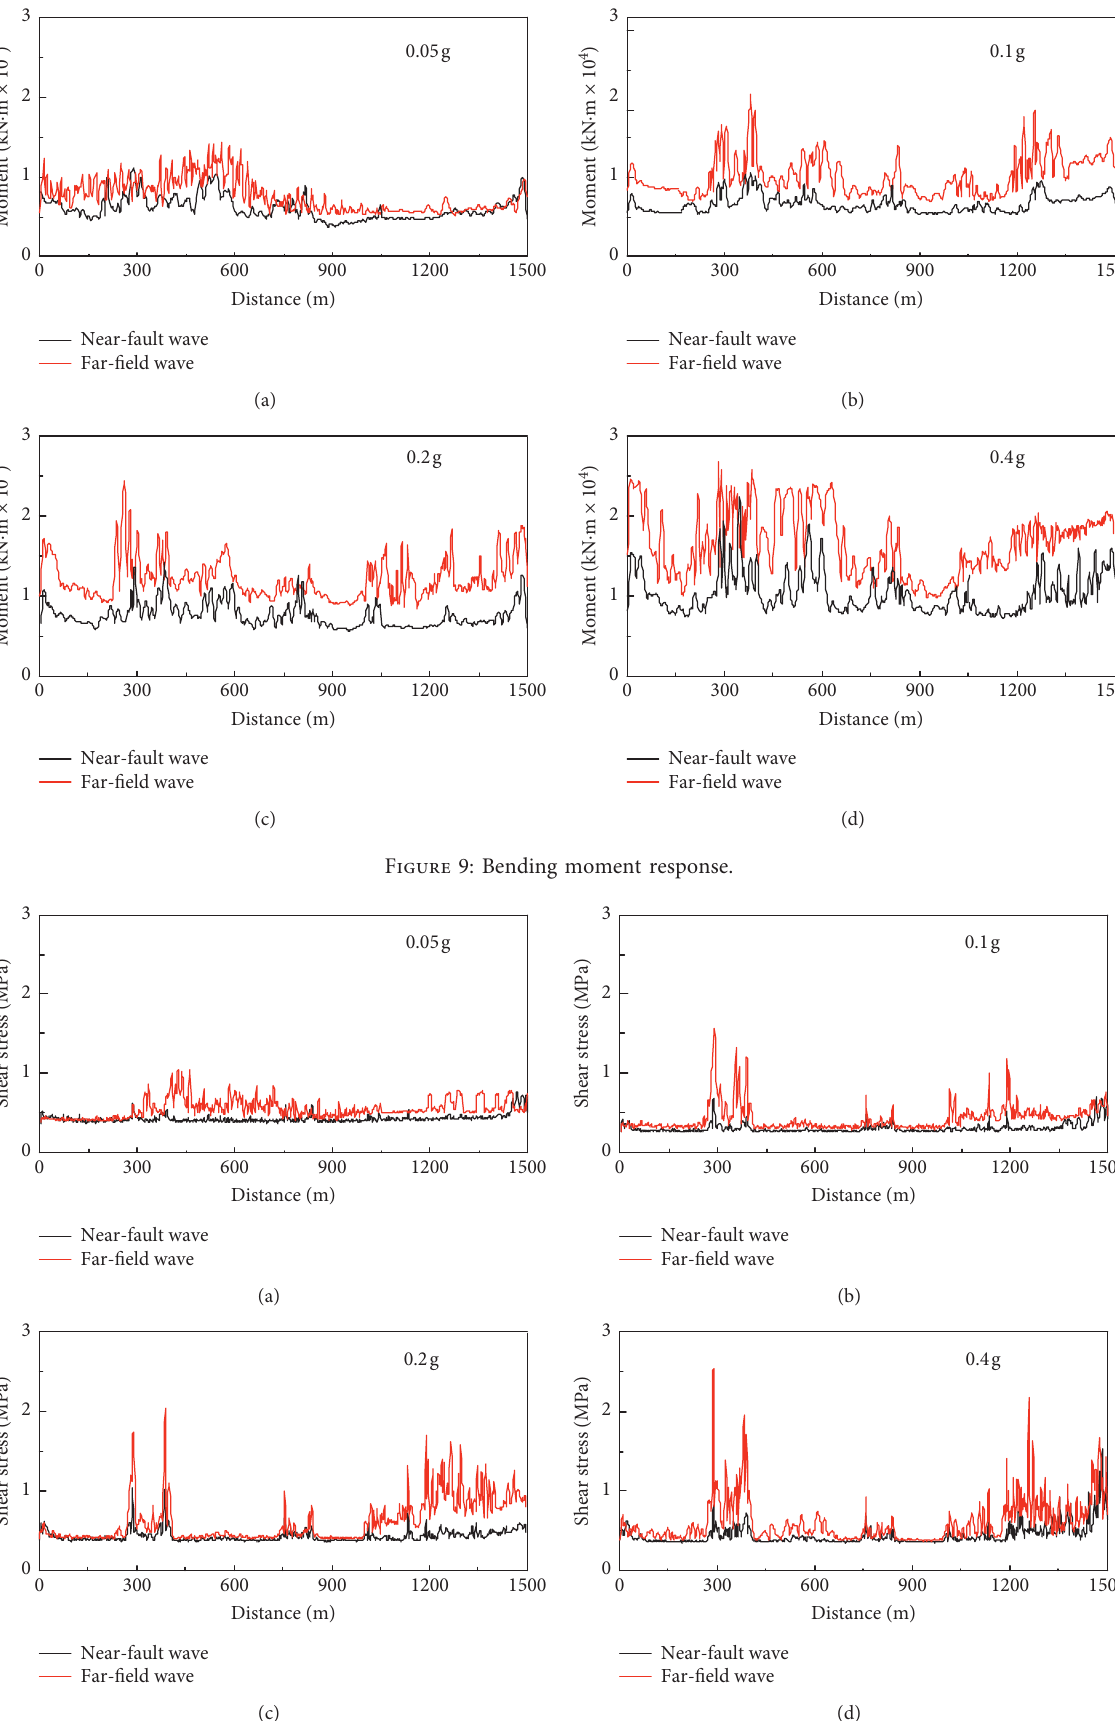
Figure 10: Shear stress